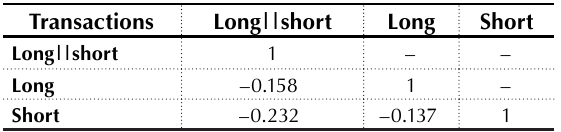
Table 8. Table of correlation coefficients between backtesting periods of the three PIVOT systems on NATGAS